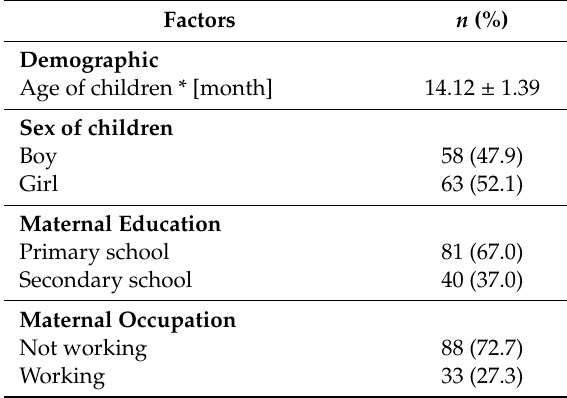
Table 1. Characteristics of the study population ( N =